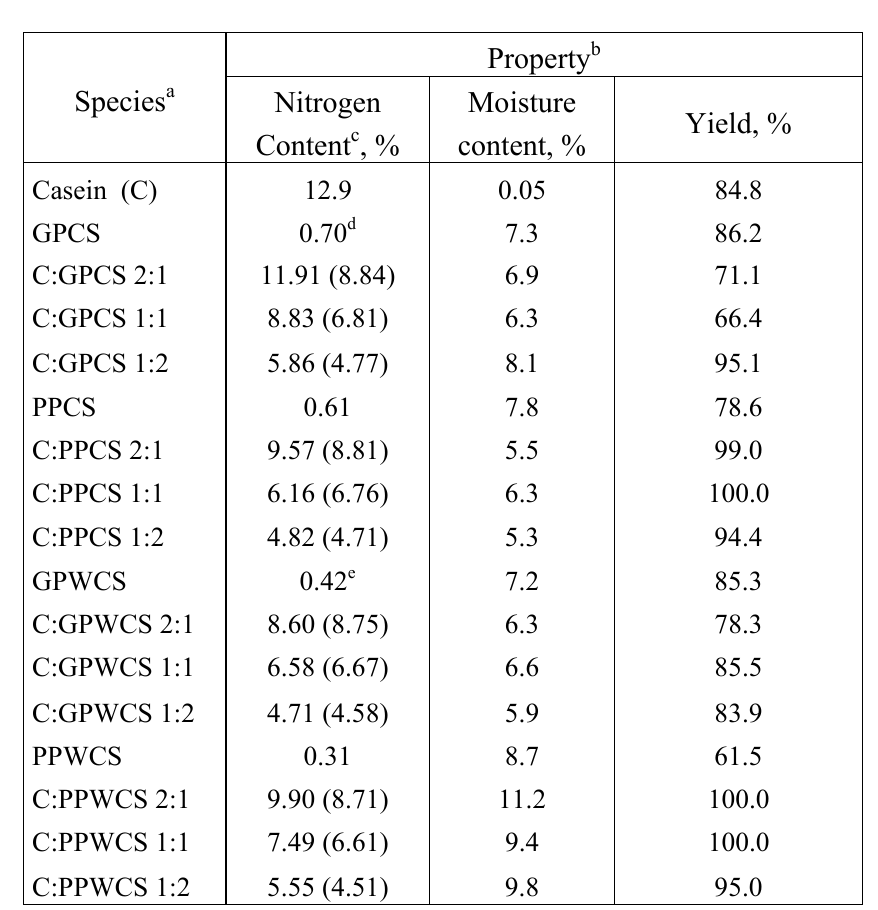
GPWCS and PPWCS and their complexes